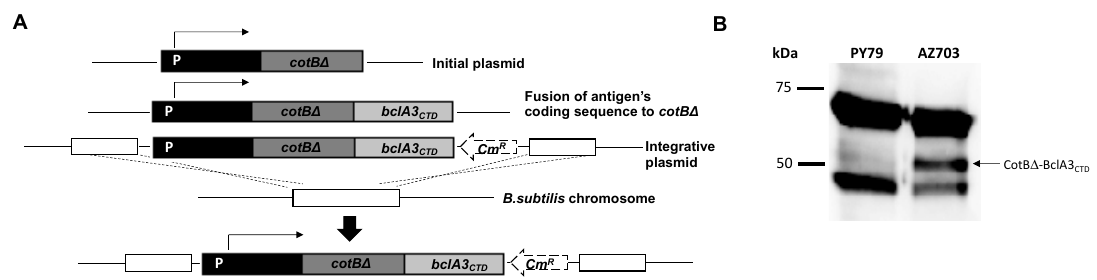
Figure 2. Construction of B. subtilis recombinant strain AZ703 expressing the chimera protein CotB Δ -BclA3 CTD . ( A ) Schematic representation of the strategy for the integration of the gene fusion cotB ∆ ::bcla3 CTD in the chromosomal DNA of B. subtilis PY79. The Western blot analysis of proteins extracted from spores of B. subtilis laboratory strain PY79 (lane 1 in B ) and from the recombinant strain AZ703 (lane 2 in B ) show bands of 66 and 46 kDa, which correspond to the endogenous CotB protein. The lane of recombinant strain AZ703 also displays a band of about 50 kDa which corresponds to the chimera protein CotB Δ -BclA3 CTD ; 5 × 10 8 of spores were resuspended in 100 µL of loading buffer and 20 µ g of protein extract was loaded in SDS-PAGE gel. The immunoreaction was performed with anti-CotB antibodies and anti-rabbit secondary antibody conjugated with horseradish peroxidase. Purified spores of strain AZ703 were used to extract surface proteins by the SDS-DTT procedure [34] and extracted proteins were analyzed by Western blot with anti-CotB antibody. CotB has a